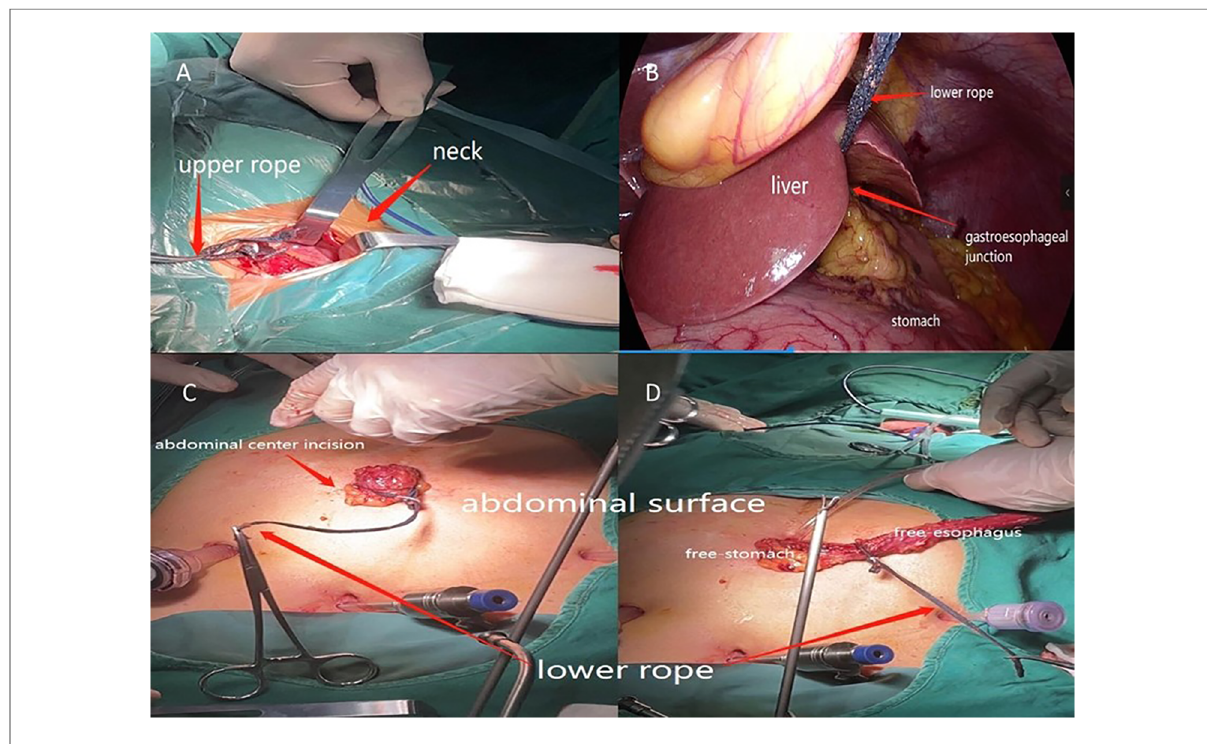
FIGURE 2 ( A ) Upper rope was used to locate and dissect the cervical esophagus. ( B ) Free-esophagus was towed by the lower rope to abdominal cavity. ( C , D ) Lower rope was used to tow the free-stomach and free-esophageal out of abdominal